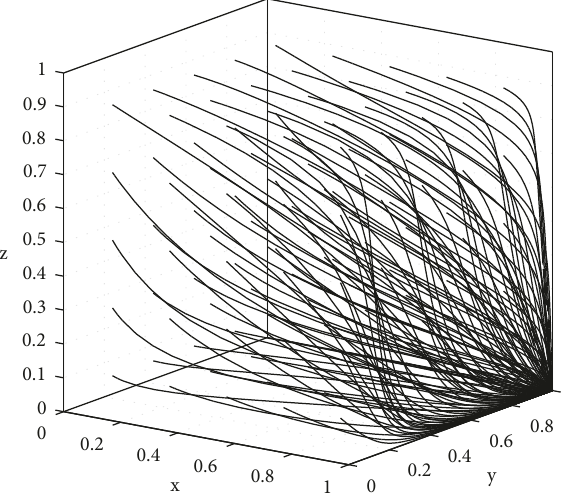
Figure 5: Dynamic evolution path of case 4.